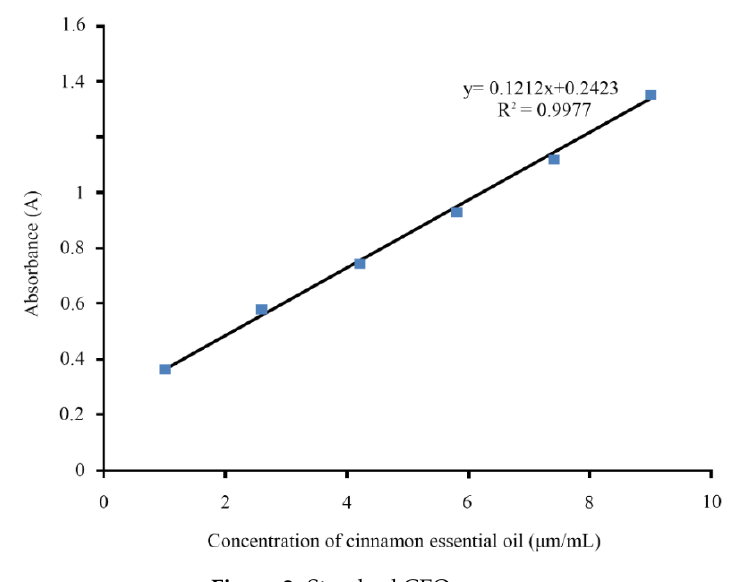
Figure 2. Standard CEO curves. Table 1. EE and LC of CEO containing CS-NPs by UV–vis